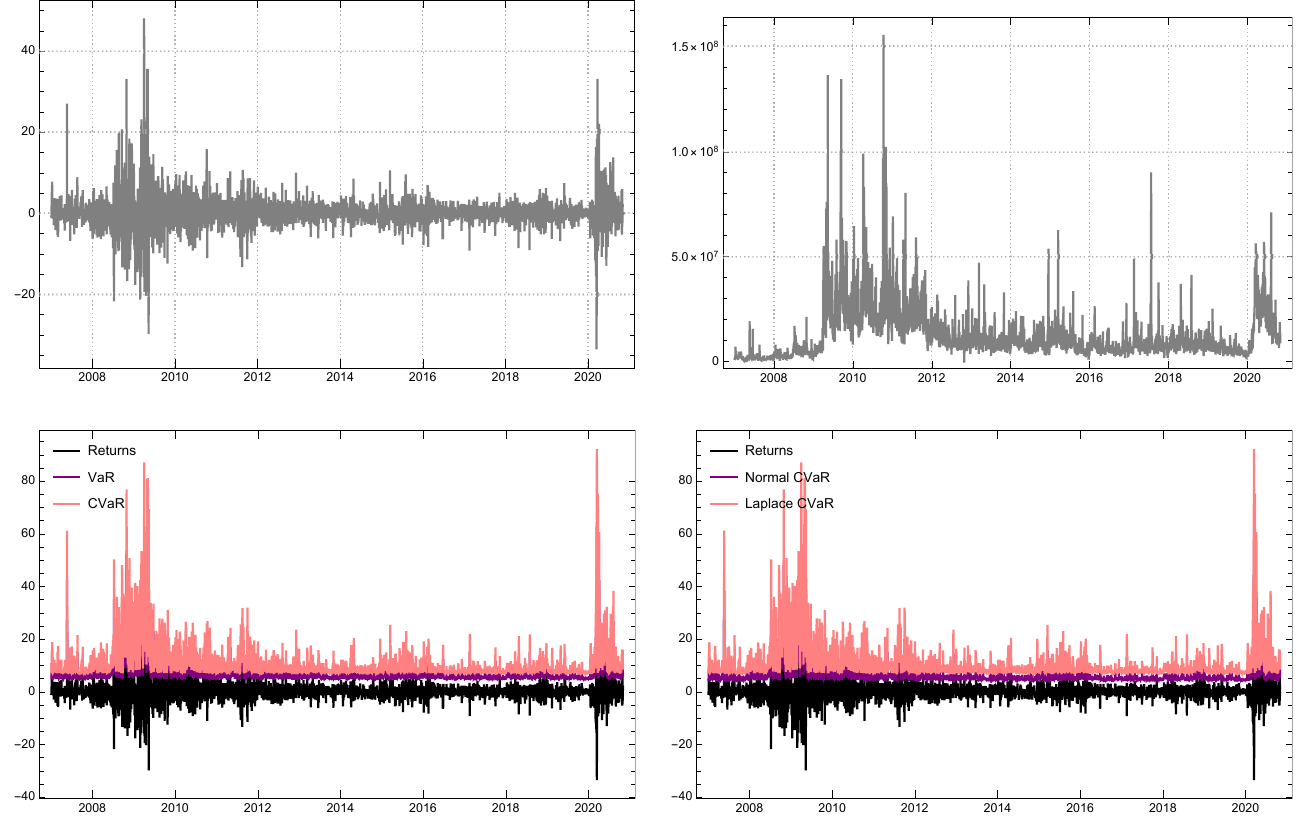
Figure 9. Computational evidence of the “NYSE:MGM” with α = 95%. ( Top left ) the fractional change over the time. ( Top right ) Its volume over the time. ( Bottom left ) Laplace VaR and CVaR comparisons. ( Bottom right ) Laplace and Normal CVaR comparisons. The horizontal axis stand for the time of